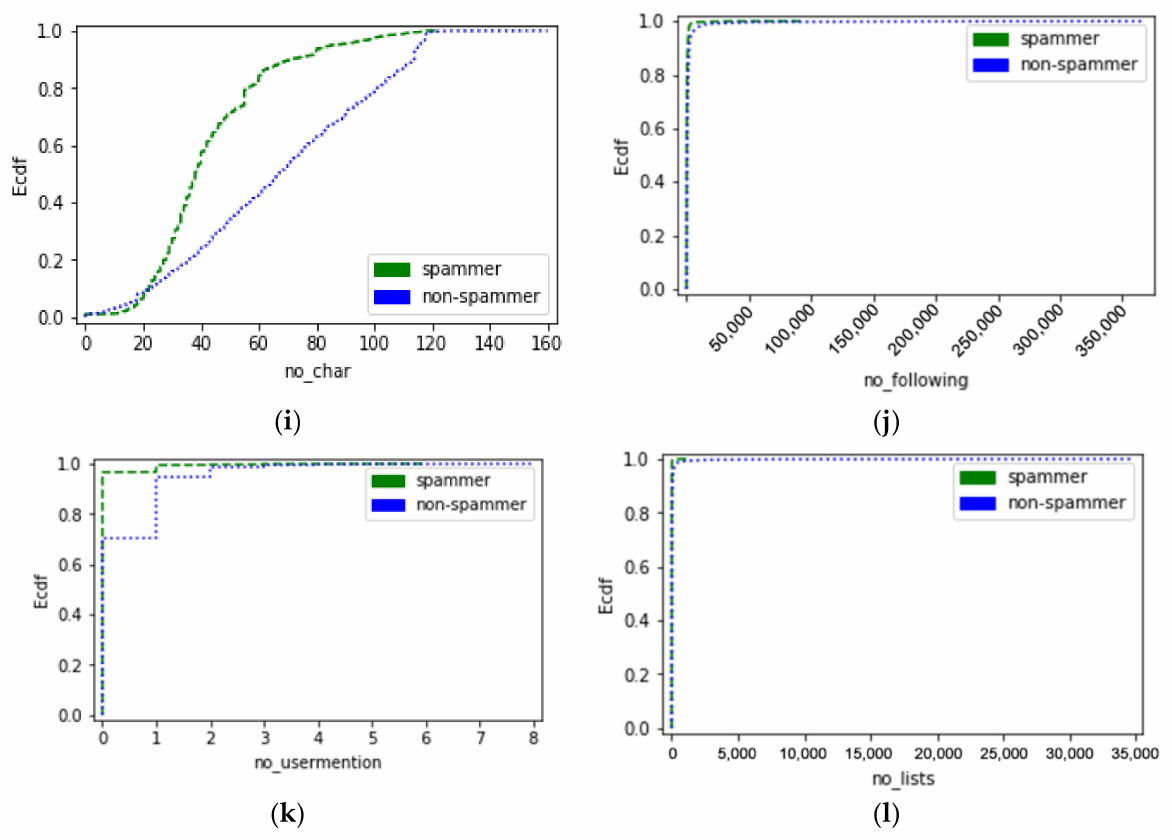
Figure 7. (ECDF) User-based features comparison: ( a ) account age; ( b ) number of followers; ( c ) number of digits; ( d ) reputation; ( e ) number of URLs; ( f ) number of user favorites; ( g ) number of retweets; ( h ) number of tweets; ( i ) number of characters; ( j ) number of followings; ( k ) number of user mentions; ( l ) number of